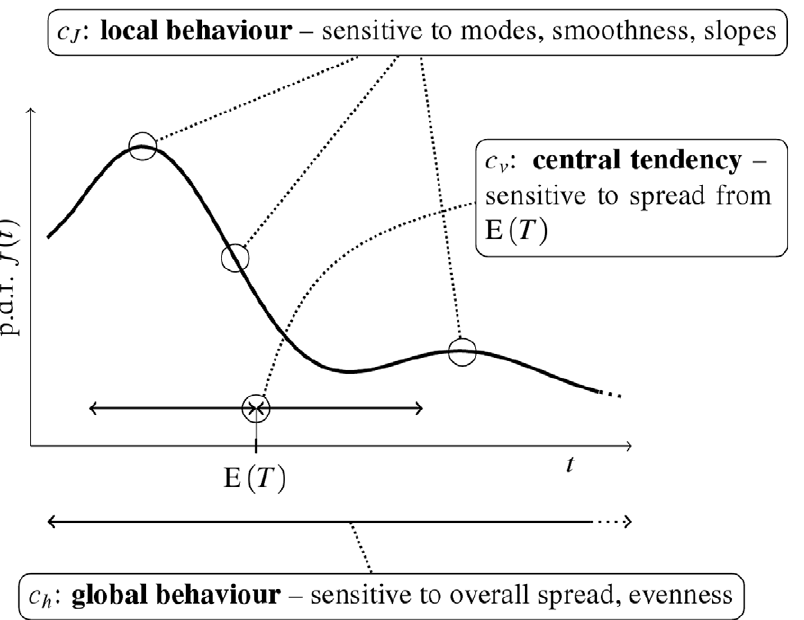
Figure 1. Illustration of the main features of the studied measures. Schematic example of a probability density function f ( t ) is shown. Although the evenness of the density (described by c h ) and its smoothness (described by c J ) are related, the sensitivity of c J to modes and slopes enables it to differentiate shapes with otherwise equal c v and c h .